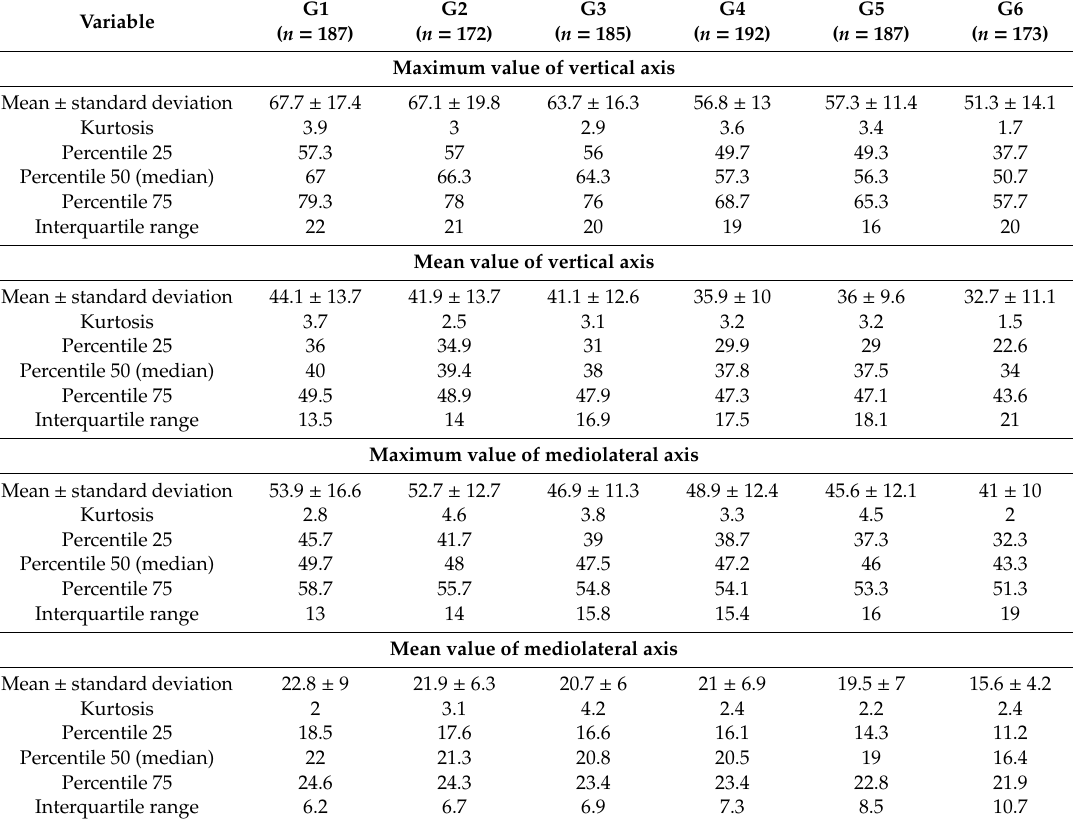
Table 2. Percentiles and descriptive statistics (in g) for the three axes and root mean square by age group. Variable